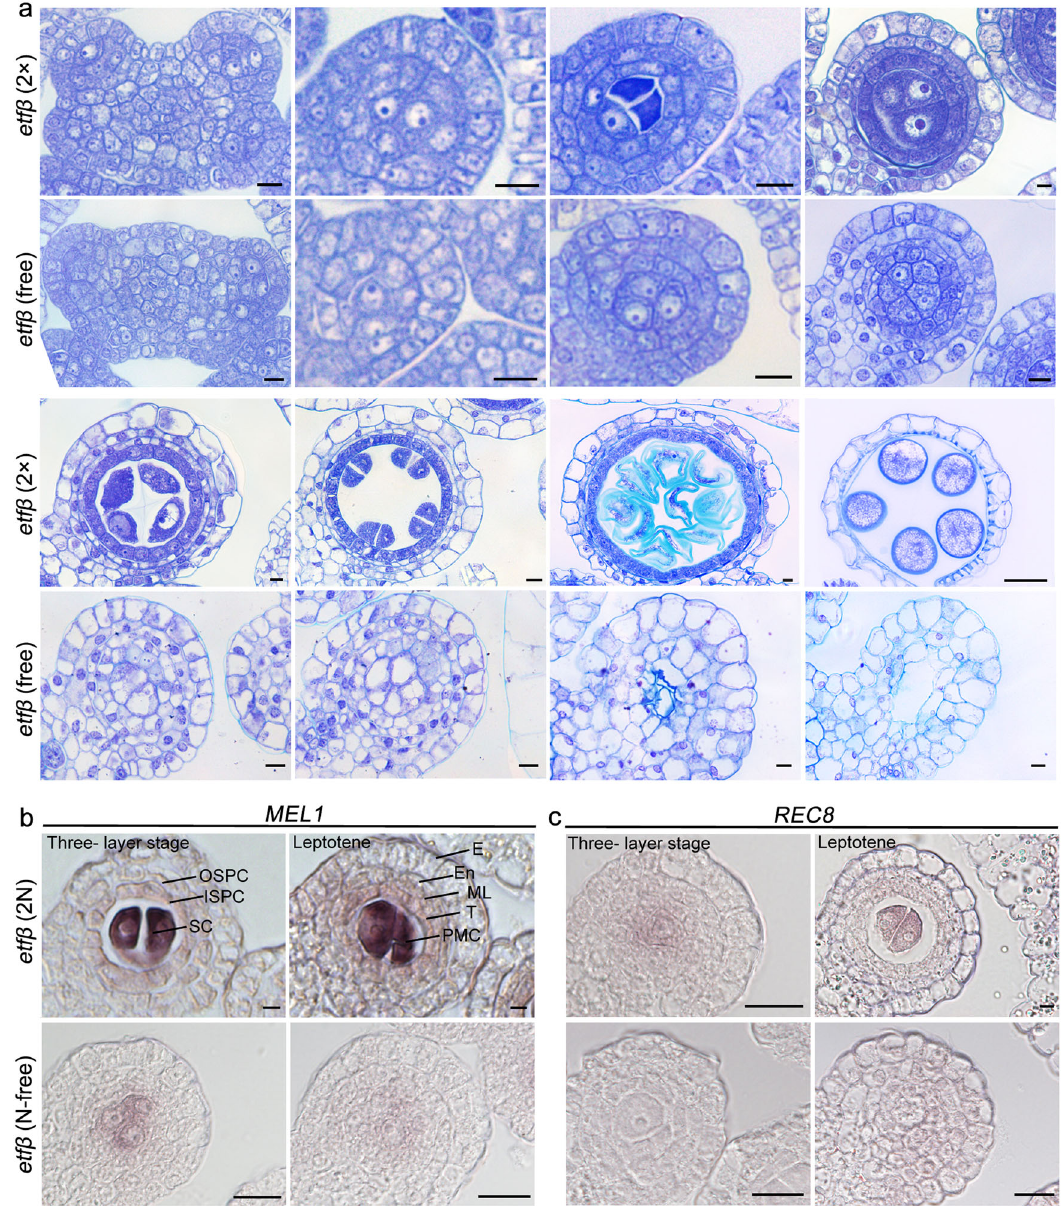
Fig. 4 Sporogenous cell progenies in etf β fail to acquire meiotic fate under N-free conditions. a TBO-stained transverse sections of anthers of etf β (2 N) and etf β (N-free). The arrows indicate abnormal apoptosis in the center of locules. SCL sporogenous cell-like cell, SCP sporogenous cell progeny. Scale bars, 5 µ m. b In situ expression analysis of MEL1 in etf β (2 N) and etf β (N-free) anthers. Scale bars, 5 µ m. c In situ expression analysis of REC8 in etf β (2 N) and etf β (N-free) anthers. Scale bars, 5 µ